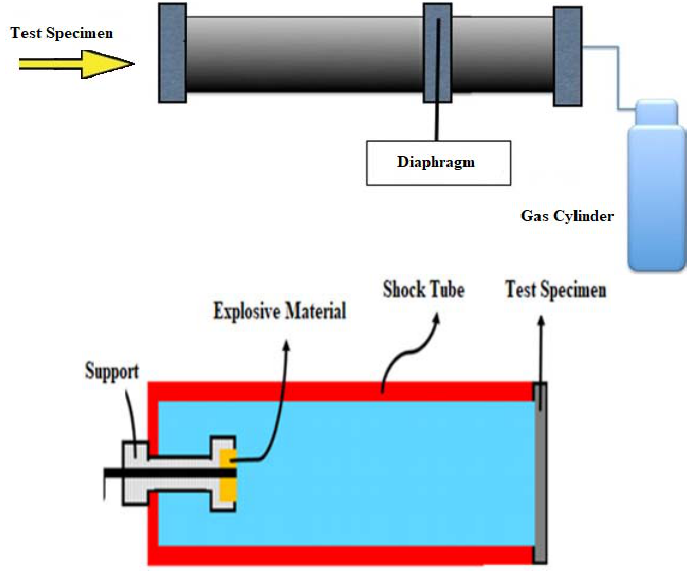
Figure 5: Schematic of compression and explosive shock